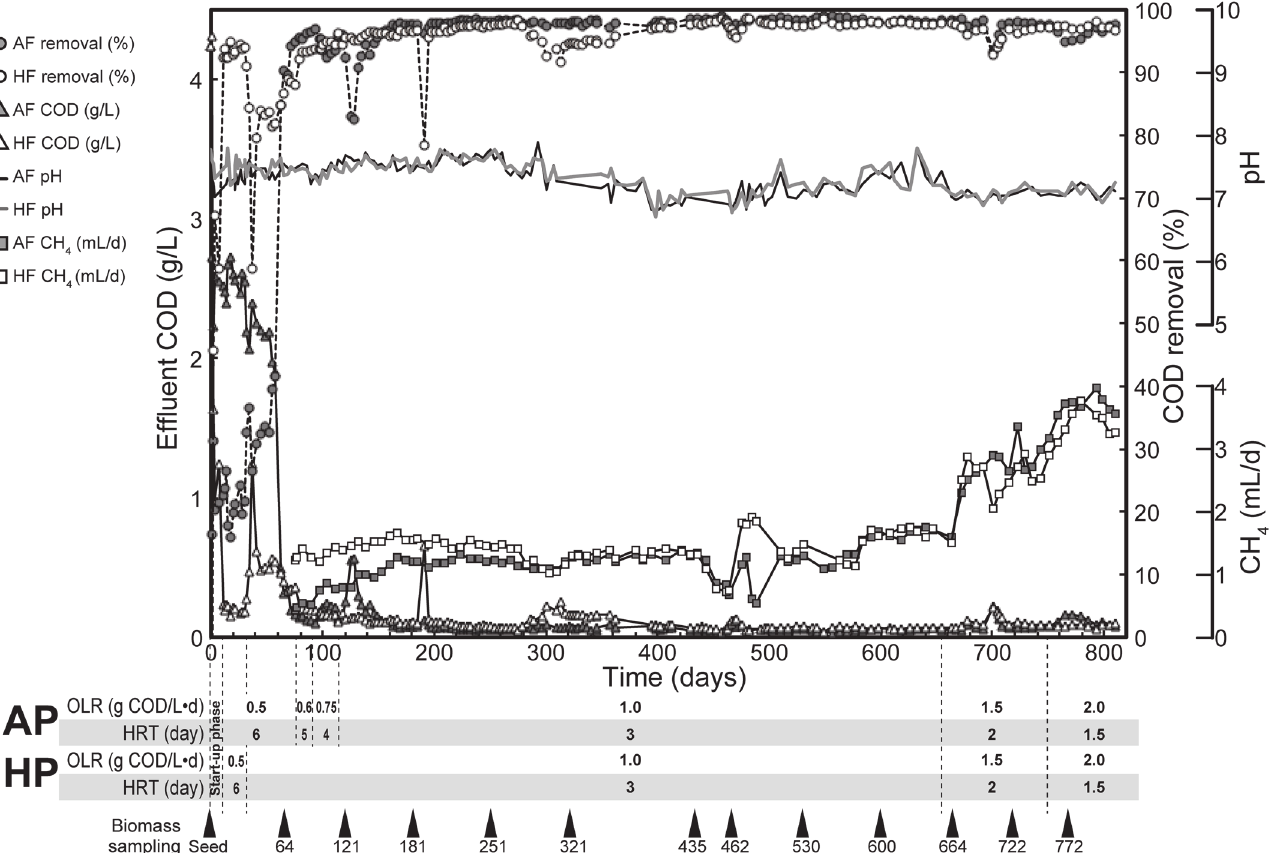
Fig 2. Changes in operational parameters of anaerobic packed-bed (AP) and hybrid packed-bed (HP) reactors. Closed circle, COD removal (%) in AP; open circle, COD removal (%) in HP; closed triangle, effluent COD concentration (g L − 1 ) in AP; open triangle, effluent COD concentration (g L − 1 ) in HP; black line, pH in AP; gray line, pH in HP; closed square, methane gas production (L d − 1 ) in AP; open square, methane gas production (L d − 1 ) in HP. The reactors were operated at different organic loading rates (OLR) ranging from 0.5 to 2.0 g-COD L − 1 d − 1 . The COD concentration of influent synthetic wastewater was decreased due to absence of polyethylene glycol 200 (1,100 mg L − 1 ) during days 398 – 411. The triangles in the bottom indicate the periods for biomass sampling from the reactors.